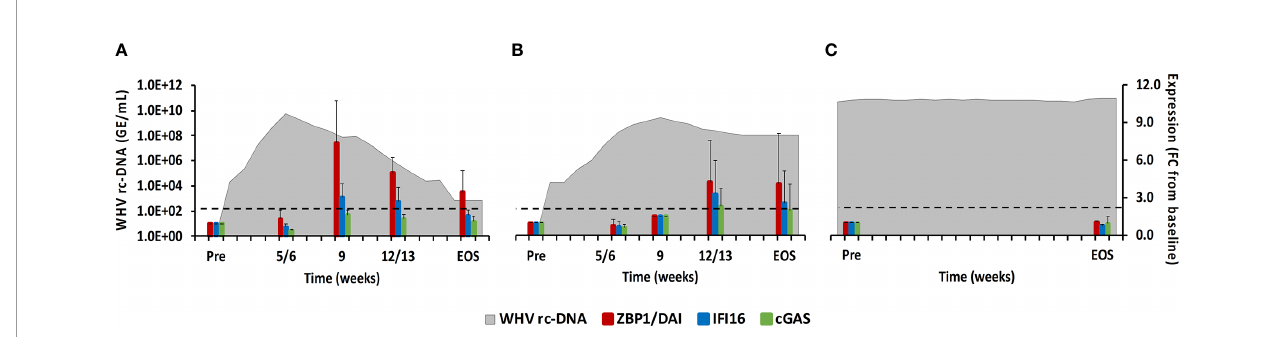
FIGURE 6 | Intrahepatic CDS expression. Expression changes of ZBP1/DA1, IFI16, and cGAS in liver with WHV rc-DNA kinetics of woodchucks during (A) AHB with normal resolution (n=5), (B) AHB with delayed resolution (n=5), and (C) CHB progression (n=3). The fold-changes in receptor transcript level are plotted on the right y-axis, while serum WHV rc-DNA loads are plotted on the left y-axis. The horizontal, dotted line indicates the cutoff for positive expression (i.e., ≥ 2.1-fold increase from the pre-inoculation baseline). Horizontal bars represent the standard error of the mean. Pre, pre-inoculation for AHB and start of study for CHB; EOS, end of study; FC, fold-change.